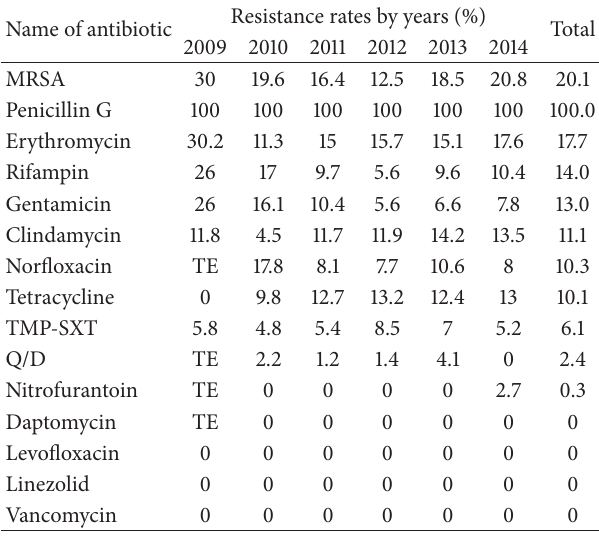
Table 3: Antibiotic resistance rates of isolated S. aureus strains by years